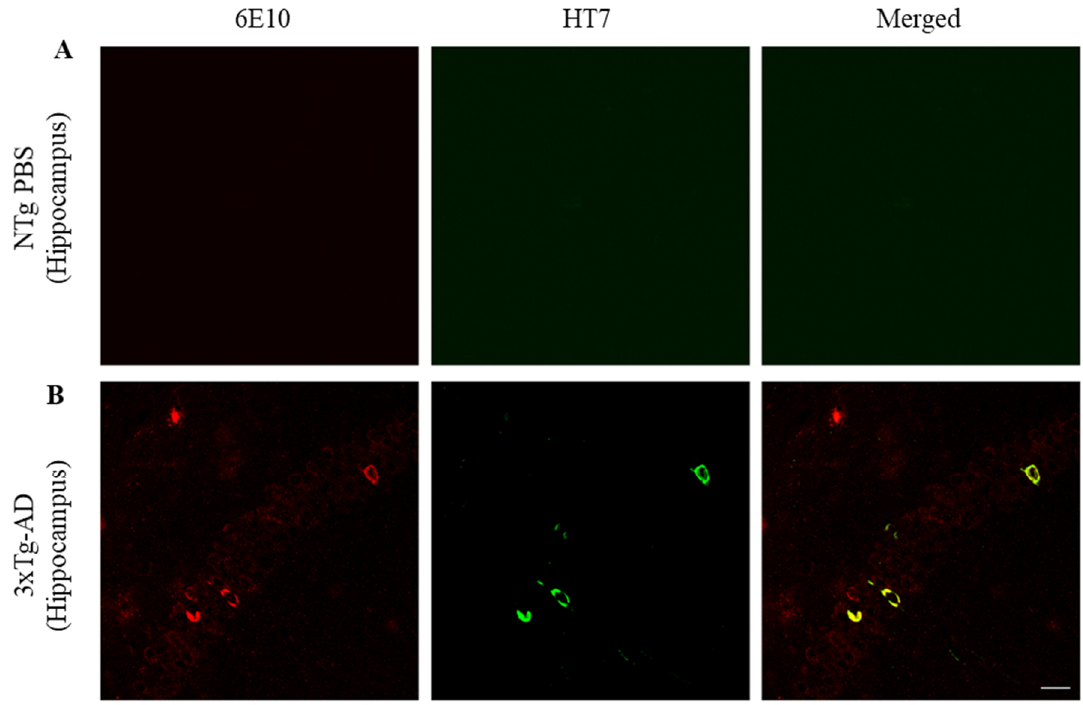
Three replicates for each experiment. Data are expressed as medians in box plots, and whiskers represent the minimum and maximum values. Statistical differences were assessed with the non- parametrical Mann-Whitney U -test. * Significant differences p ≤0.05; # Marginal significance p ≤ 0.1; § r ≥ 0.68.